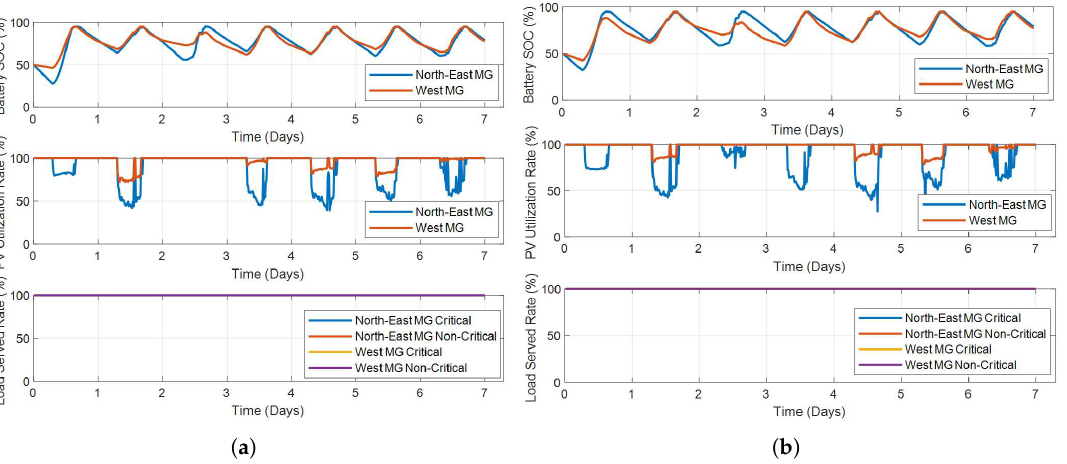
Figure 13. Optimization results of Adjuntas 2-microgrid system in Case 1. ( a ) Centralized Method. ( b ) Distributed Method.